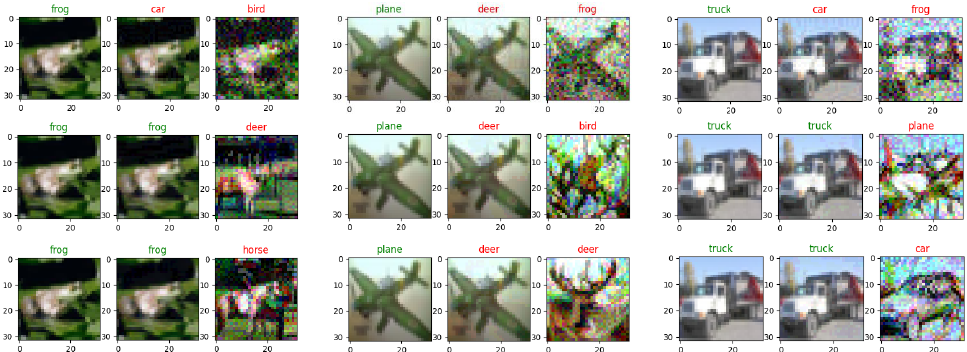
Figure 3. Sample images from the CIFAR-10 dataset, with corresponding adversarial examples. The first row represents the adversarial examples and predicted values obtained by the normal model, the second row represents the SAT model, and the third row represents the AT-SVM model. We show the original image and adversarial examples for epsilons of 0.03 and 0.3.